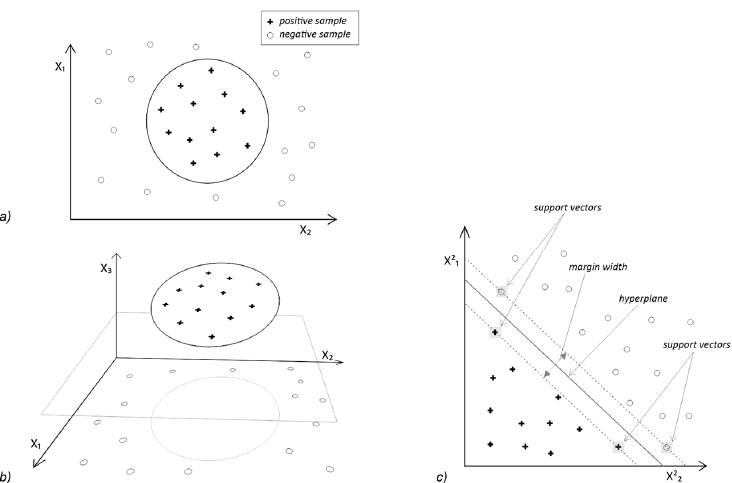
Figure 3. Principle of finding the linear solution of classification by augmenting the dimensionality: ( a ) sample of training data with positive and negative values, where linear separation is not possible; ( b ) data space with augmented dimensionality, enabling to find a plane, separating the data; and ( c ) separating hyperplane with margins, defined by the support vectors.